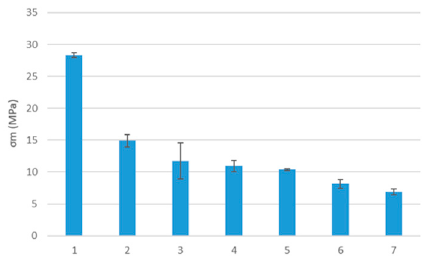
Figure 15. Relative elongation. Samples: (1) HDPE, (2) HDPE with 20% filler content, (3) HDPE with 40% filler content, (4) HDPE with 50% filler content, (5) HDPE with 60% filler content, (6) HDPE with filler content 70%, (7) HDPE with a filler content of 80%.